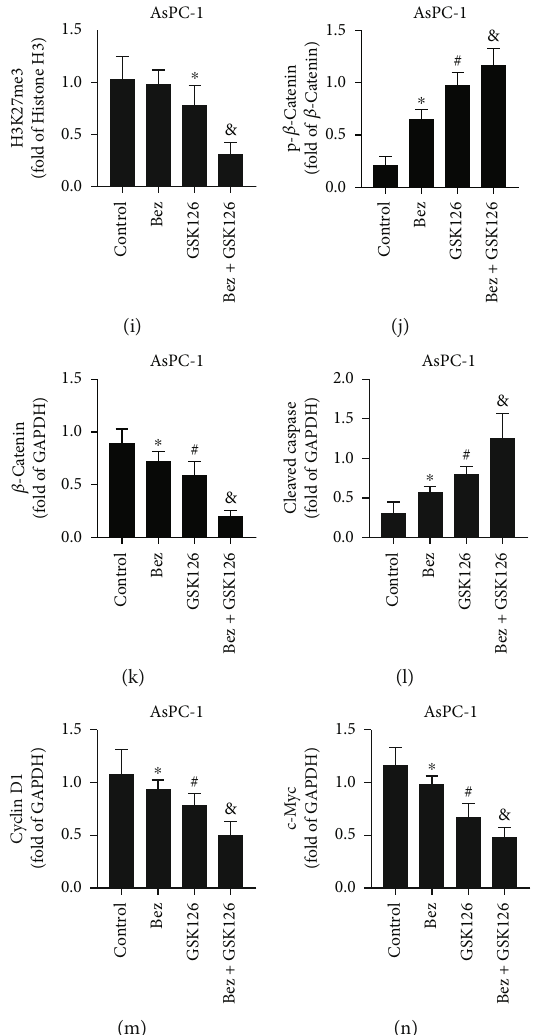
Figure 4: E ff ects of combination of beza fi brate and GSK126 on protein expressions in cells of PANC-1 and AsPC-1. (a) Representative bands of western blot of H3K27me3, p- β -catenin, β -catenin, and cleaved caspase 3 in cells of PANC-1. (b) Representative bands of western blot of H3K27me3, p- β -catenin, β -catenin, and cleaved caspase 3 in cells of AsPC-1. (c) The relative band intensity of H3K27me3 in each experimental group of PANC-1 cells. (d) The relative band intensity of p- β -catenin in each experimental group of PANC-1 cells. (e) The relative band intensity of β -catenin in each experimental group of PANC-1 cells. (f) The relative band intensity of cleaved caspase 3 in each experimental group of PANC-1 cells. (g) The relative band intensity of cyclin D1 in each experimental group of PANC-1 cells. (h) The relative band intensity of c-Myc in each experimental group of PANC-1 cells. (i) The relative band intensity of H3K27me3 in each experimental group of AsPC-1 cells. (j) The relative band intensity of p- β -catenin in each experimental group of AsPC-1 cells. (k) The relative band intensity of β -catenin in each experimental group of AsPC-1 cells. (l) The relative band intensity of cleaved caspase 3 in each experimental group of AsPC-1 cells. (m) The relative band intensity of cyclin D1 in each experimental group of AsPC-1 cells. (n) The relative band intensity of c-Myc in each experimental group of AsPC-1 cells. The values were expressed as the means ± S : E : M : ( n = 6 for each group). ∗ P < 0 : 05 vs. the control group, # P < 0 : 05 vs. the Bez group, and & P < 0 : 05 vs. the GSK126